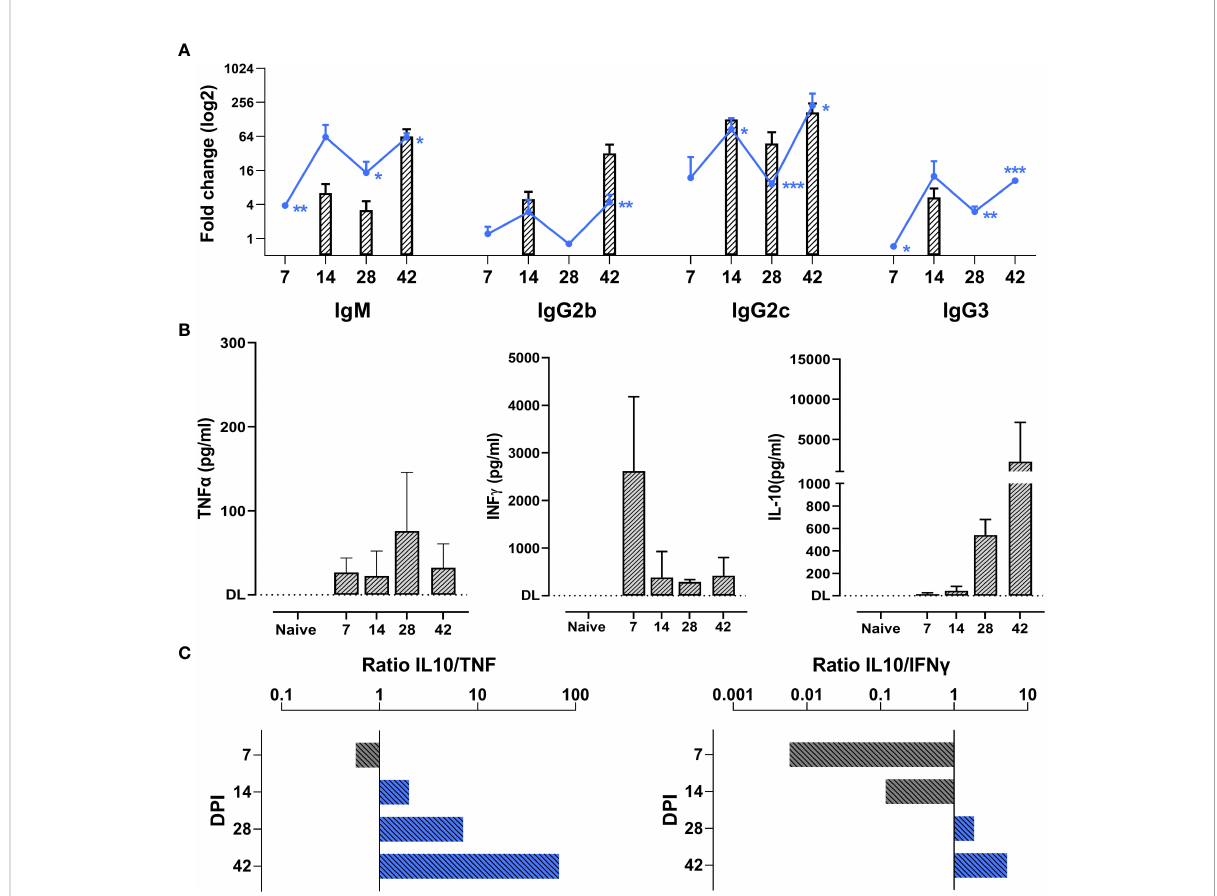
FIGURE 2 Chronic T. evansi Merzouga 93 infection hallmarked by high antibody titers and anti-in fl ammatory cytokine response. (A) Total antibodies titers (line graphs) and anti-VSG antibodies titers (bar graphs). Results present log2 fold change of OD50 values (for total antibodies) or end-point titer (for anti-VSG antibodies) of infected mice vs naïve sample. For anti-VSG antibodies titers, only signi fi cant values when compared with naïve (p ≤ 0.05) are presented. *p ≤ 0.05; **p ≤ 0.01, ***p ≤ 0.001 by Student t-test vs naïve values. (B) Concentration of TNF a , INF ɣ , and IL-10 in blood plasma during infection. DL: detection limit. Data presents mean + SD from 3 individual mice from one representative among three independent experiments. (C) IL-10/TNF a and IL-10/INF ɣ ratios, computed by dividing the average IL-10 concentration by the average TNF and INF g concentrations at the same time